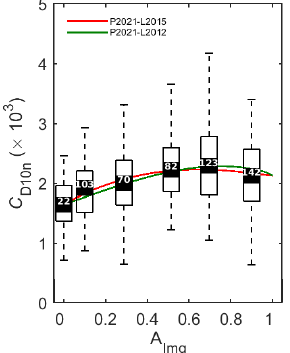
Figure 8. C D10n as a function of the local ice fraction ( A Img ) for the joint ACSE and AO2016 ( n = 542) dataset. Here, the pro- posed parameterization (red line, P2021–L2015) is presented with L2015 anchored at the observed values of C D10nw ( A Img = 0) and C D10ni ( A Img > 0.8) with the coefficients β and c e shown in Table 1. For comparison, the L2012 scheme (green line, P2021–L2012) is also tuned with the curve anchored at the same values of C D10ni and C D10nw with β and c e shown in Table